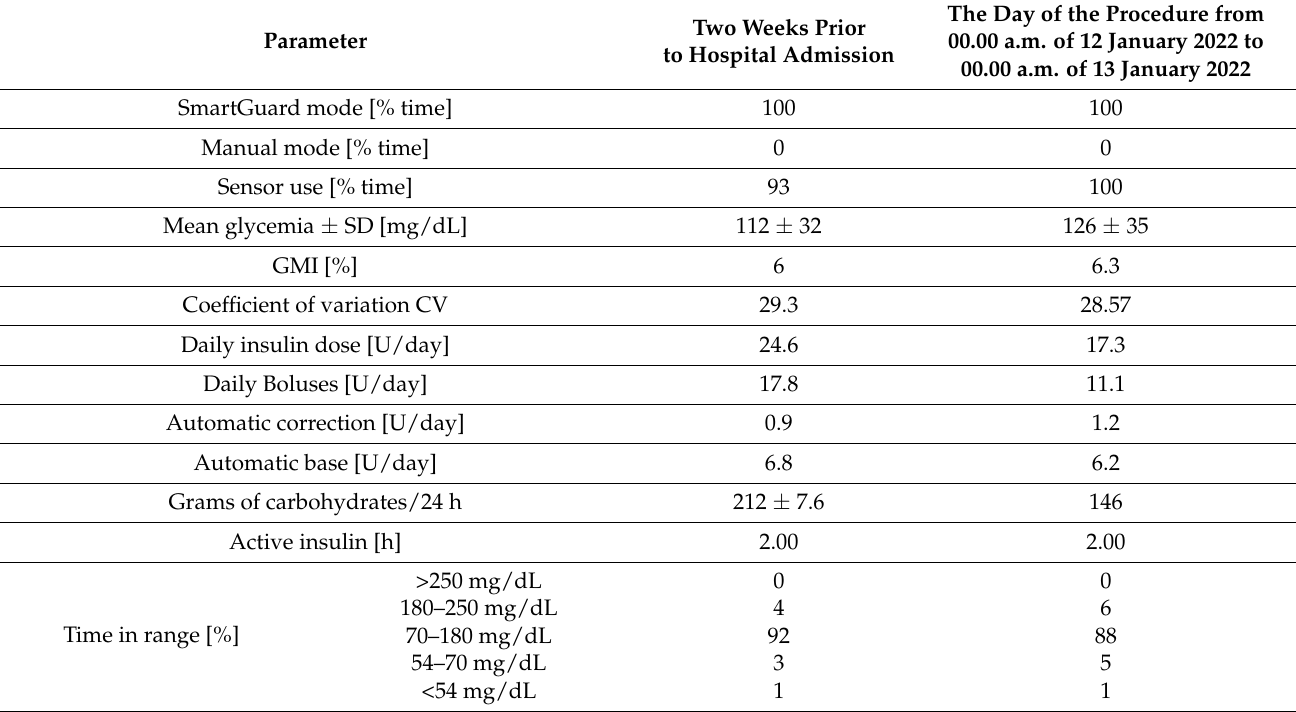
Table 1. AHCL report 2 weeks prior to hospital admission and on the day of the